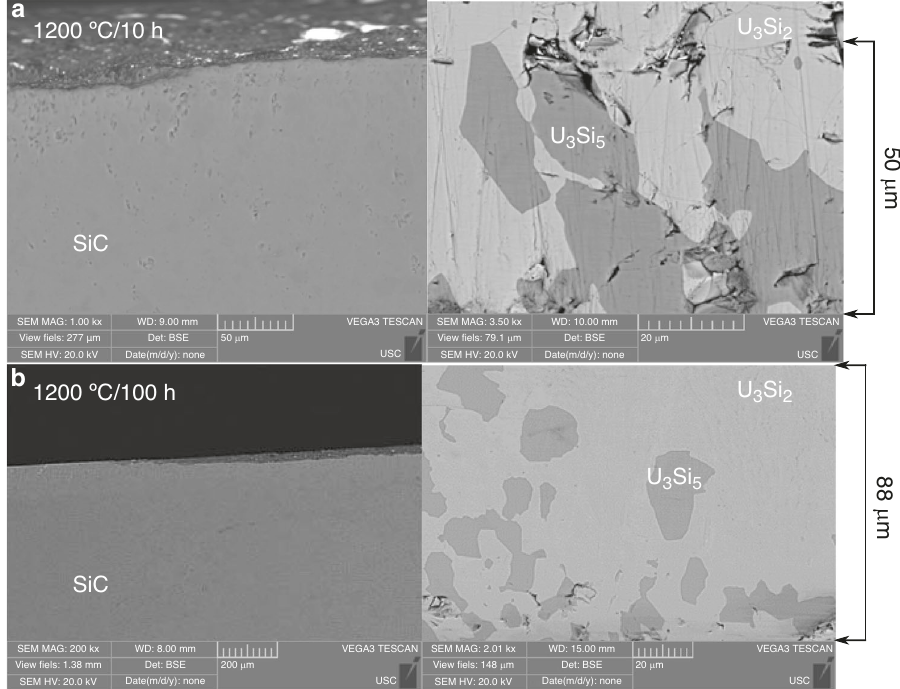
Fig. 1 SEM analysis of U 3 Si 2 and SiC. Polished cross-section of the U 3 Si 2 and SiC surfaces after exposure at 1200 °C for: ( a ) 10 h, and ( b ) 100 h. The depth of Si diffusion into the U 3 Si 2 can be seen in the formation of U 3 Si 5 well below the